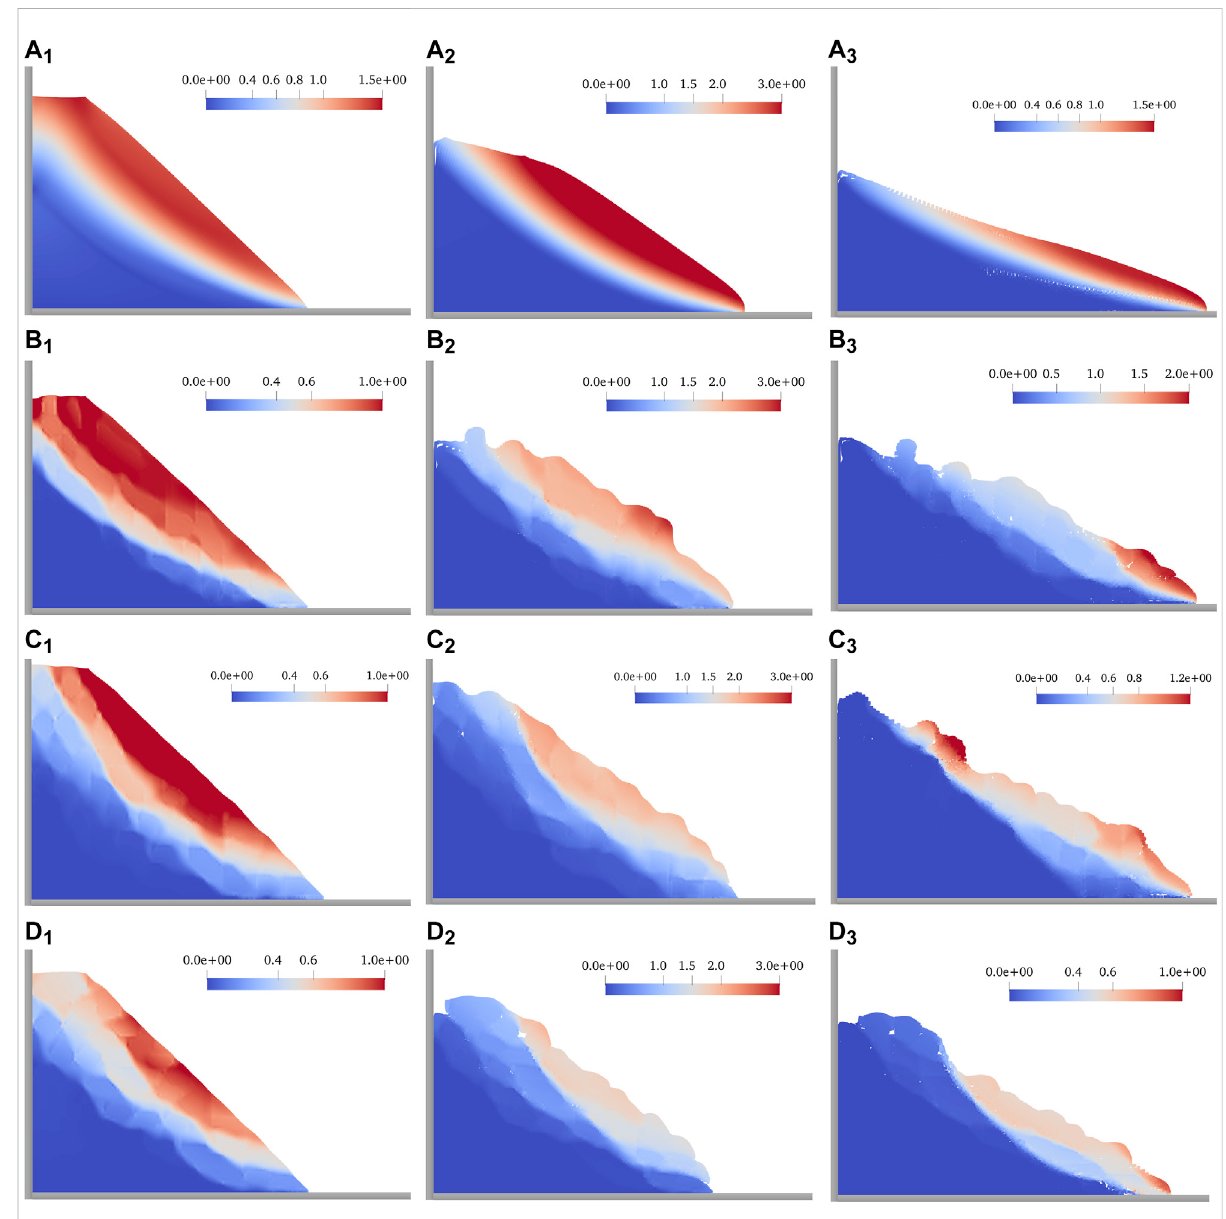
FIGURE 5 Rate cloud maps. (A 1 ) ~ (A 3 ) Rate (m/s) distribution of the homogeneous soil slope at 0.5, 1.6, and 3.5 s. (B 1 ) ~ (B 3 ) Rate (m/s) distribution of the SRM slope (arbitrary shapes stones) at 0.5, 2.0 and 3.5 s. (C 1 ) ~ (C 3 ) Rate (m/s) distribution of the SRM slope (round stones) at 0.5, 1.5, and 3.5 s. (D 1